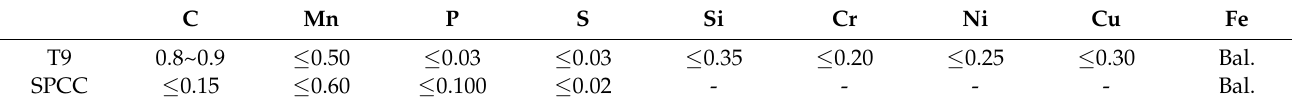
Table 1. Chemical composition (mass fraction) of T9 steel and SPCC